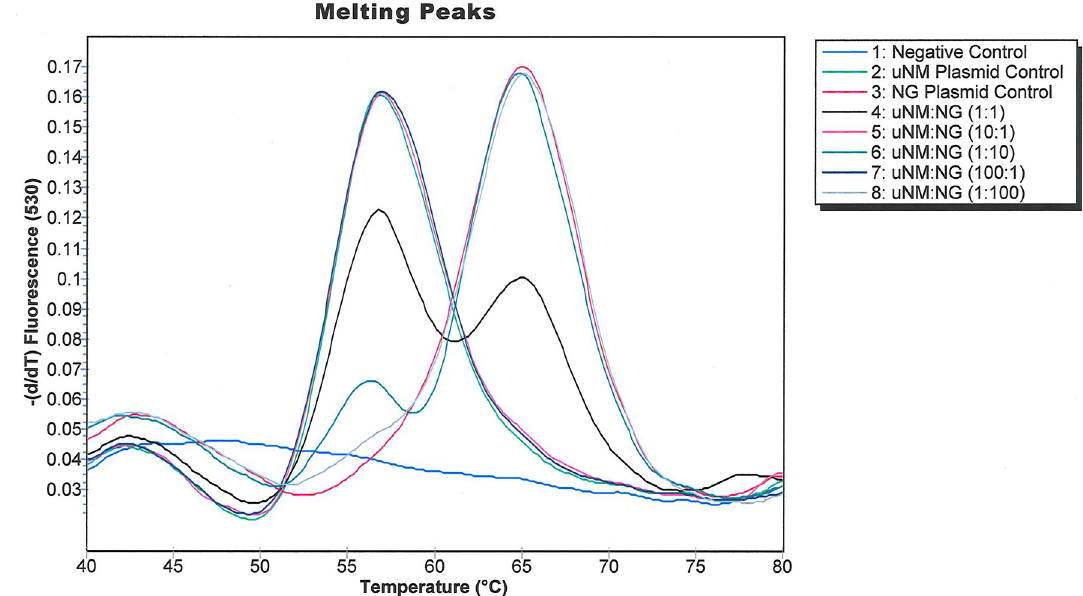
Fig 3. Amplification curves generated when the SimpleProbe 1 US_NmUC assay was tested against various dilutions of NG and NM.